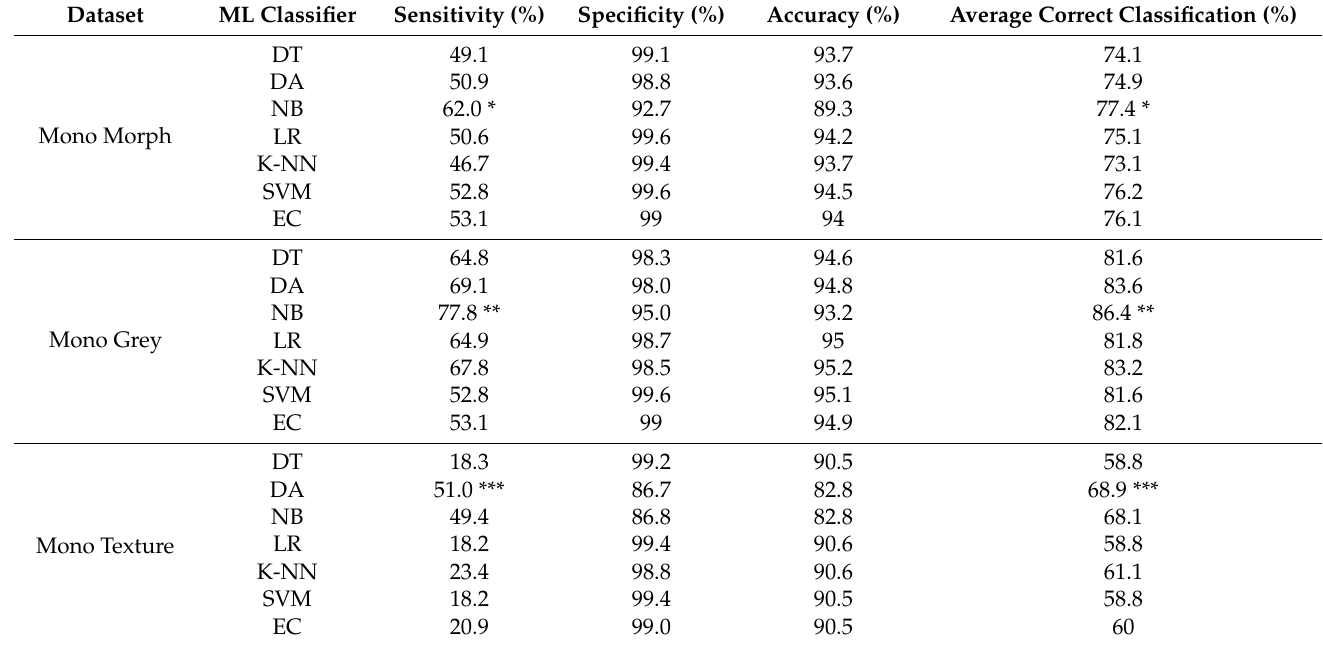
Table 5. The classification performance of the Monochrome image datasets for the morphology, greyscale and texture